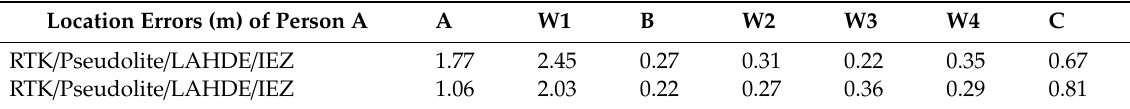
Table 3. Comparison of location errors of Person A and Person B.